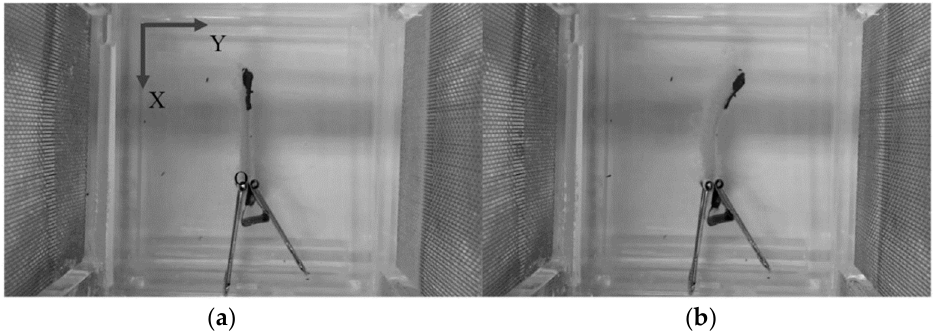
Figure 8. ( a ) An example of input signal for model identification (2 V). ( b ) Membership function of T-S model.